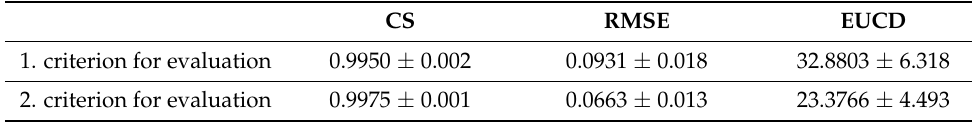
Table 1. Average difference with STD of AOT database